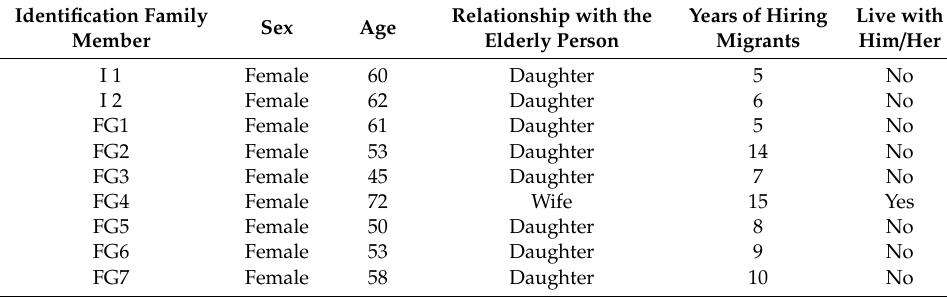
Table 1. Characteristics of the